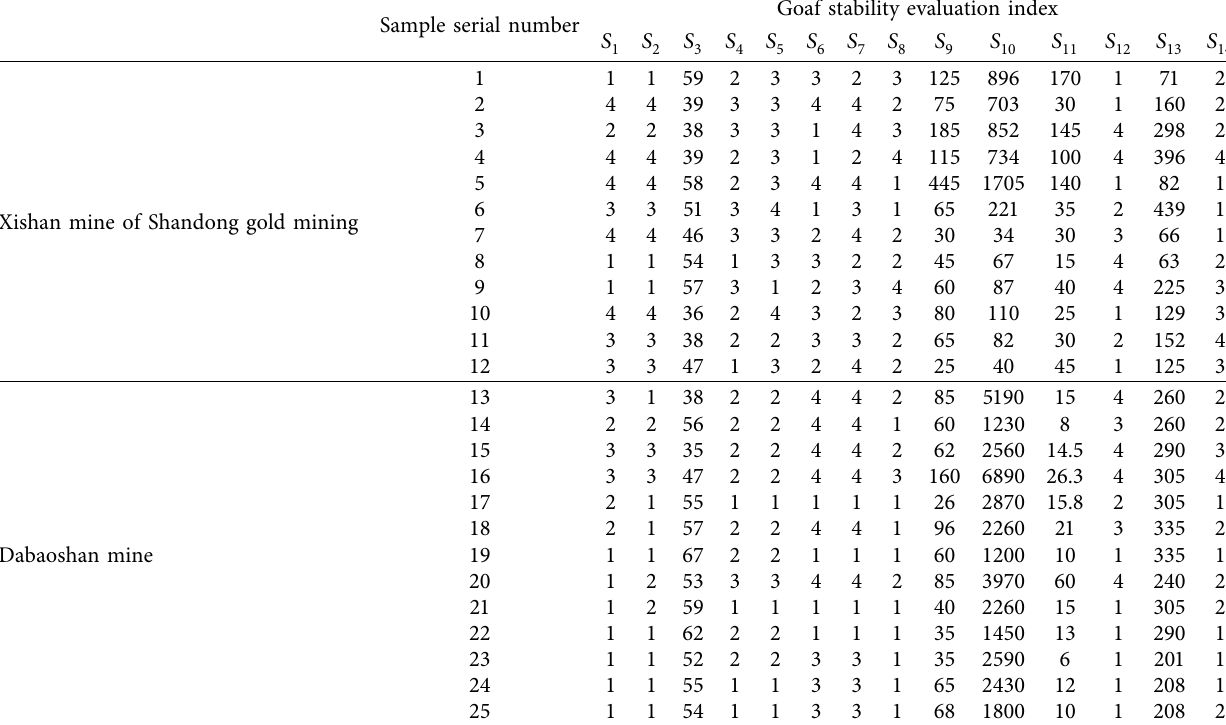
Table 3: Measured data of influencing factors and indicators of goaf stability.